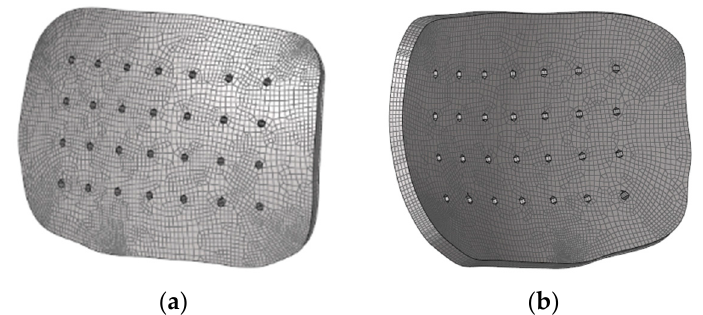
Figure 2. Different views of the implant mesh: ( a ) exterior surface; ( b ) interior surface.